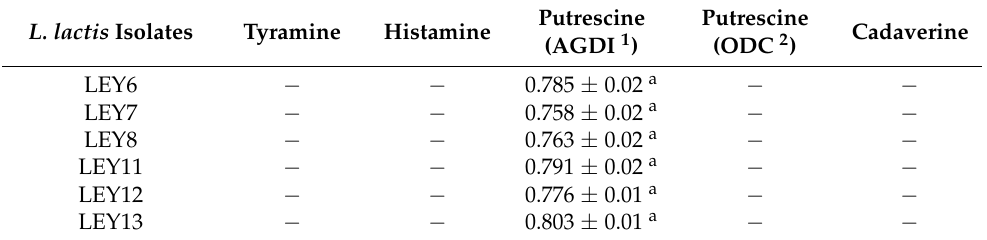
Table 5. Biogenic amine production (mM; mean ± standard deviation) in cultures of L. lactis isolates.